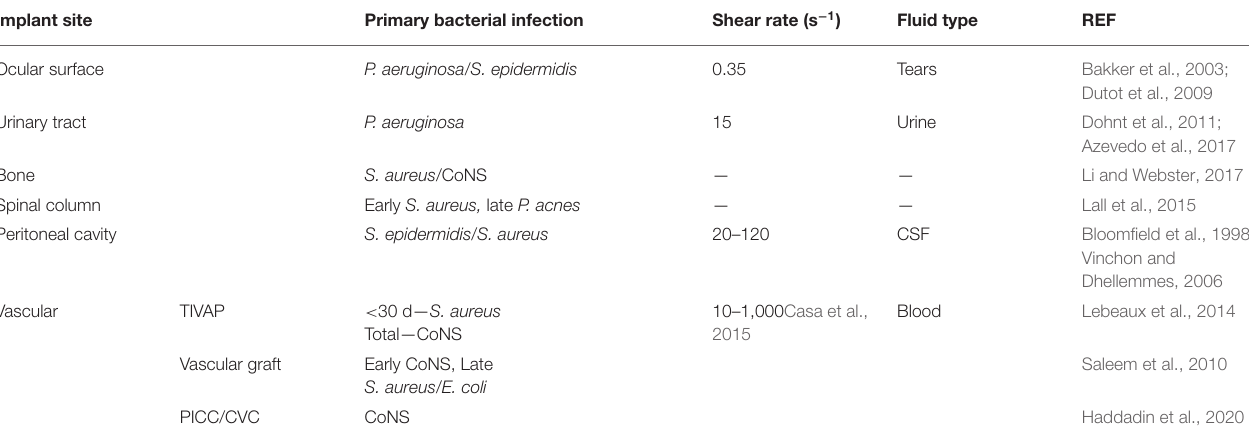
TABLE 4 | Primary bacterial infections and conditions by implant